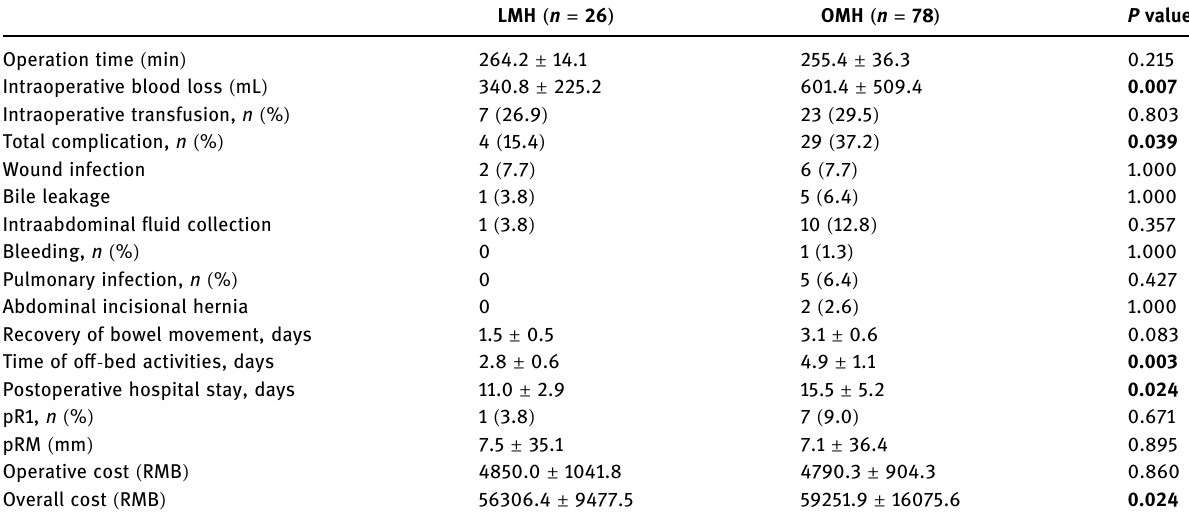
Table 2: Operative outcomes